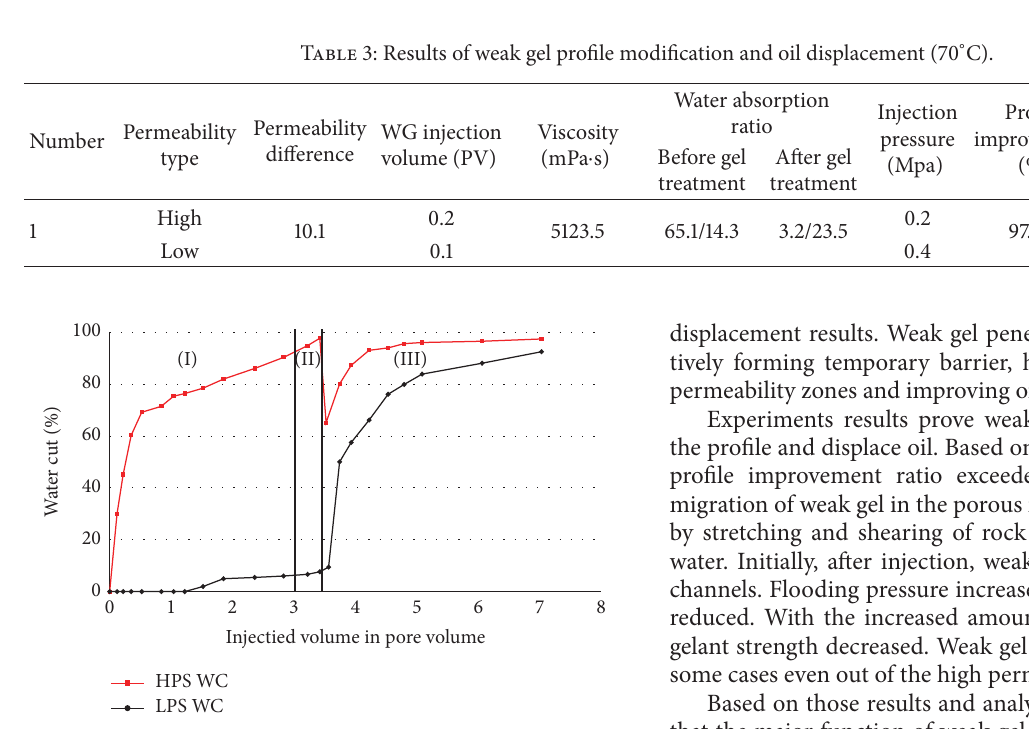
Figure 8: Water cut curves ((I) water injection, (II) weak gel injection, and (III) water injection).